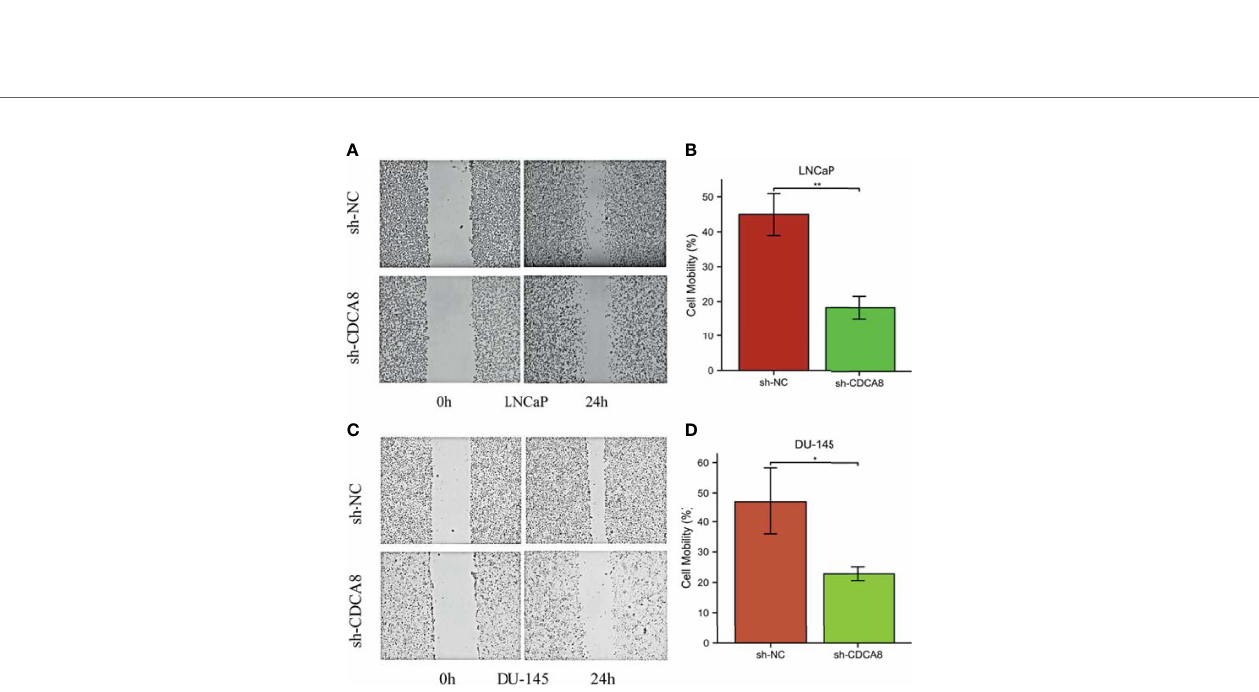
FIGURE 10 | Knockdown of CDCA8 inhibited the migration of PCa cells in vitro. (A, C) Wound healing assay, LNCaP and DU-145 at 0 and 24 h, respectively. (B, D) Relative migration distance was analyzed in LnCap and DU-145 cells, respectively. *P < 0.05; **P < 0.01;